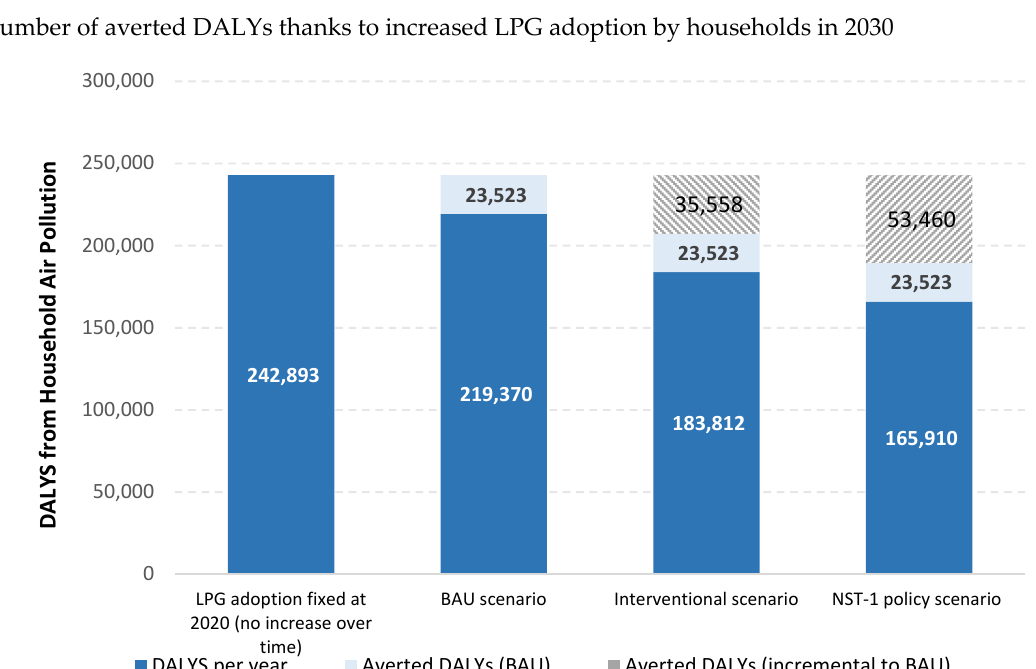
institutional cooking.